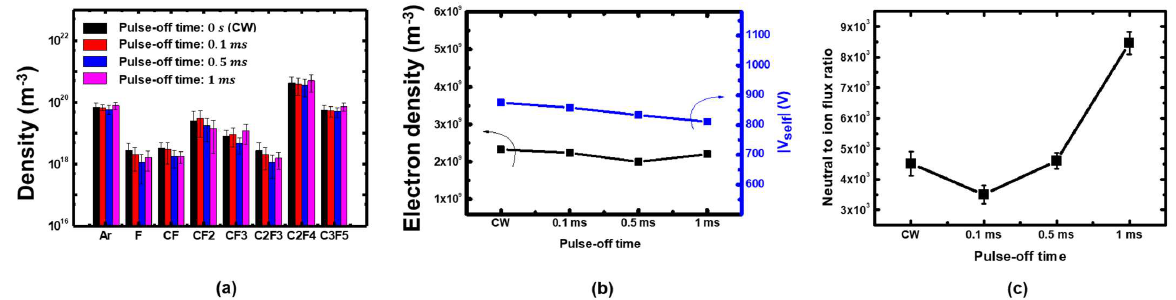
Figure 8. ( a ) Absolute neural species densities, ( b ) electron densities and self-bias voltages, ( c ) calculated neutral to ion flux ratios based on the measurement data in the pulse-modulated plasmas with various pulse-off time in C 4 F 8 80%.